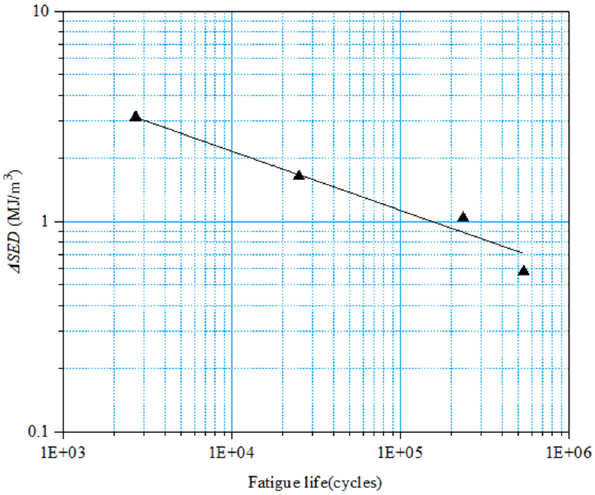
∆ SED–N f curve of Figure 7. Δ SED–N f curve of abrasion. Figure 7. Figure 7. Δ SED–N f curve of abrasion.